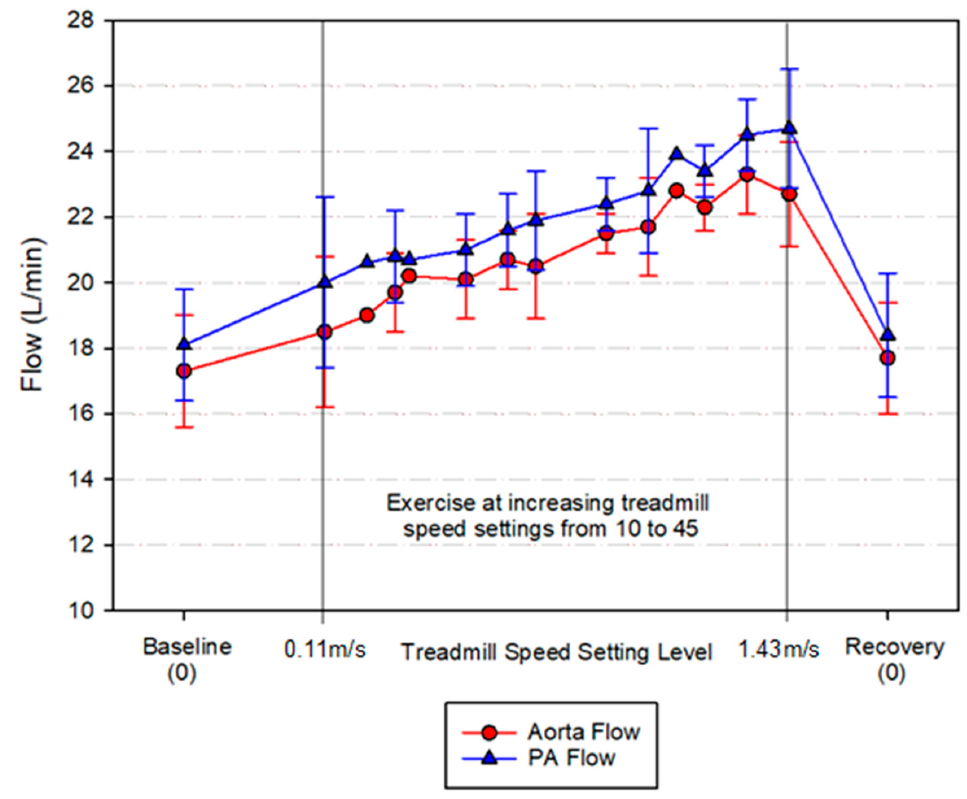
Figure 4. Aorta and pulmonary artery (PA) blood flow during treadmill exercise evaluations. Flow is displayed at baseline and recovery, as well as during exercise at increasing treadmill speed settings from 0.11 m/s to 1.43